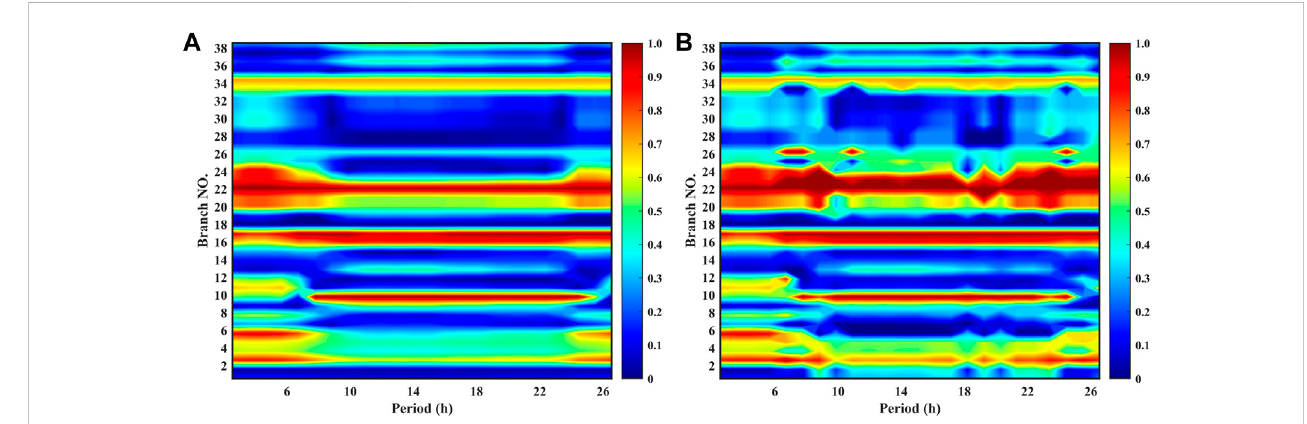
FIGURE 5 The utilization of each branch during scheduling maintenance periods 3 – 26 h. (A) Without NTO, (B) with